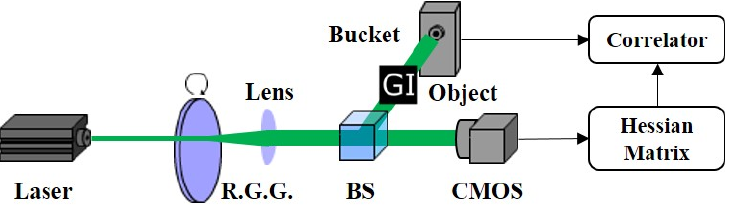
Figure 1. Experiment system: RGG: rotating ground glass; BS: 50:50 beam splitters; Object: “GI” (ghost imaging) pattern.